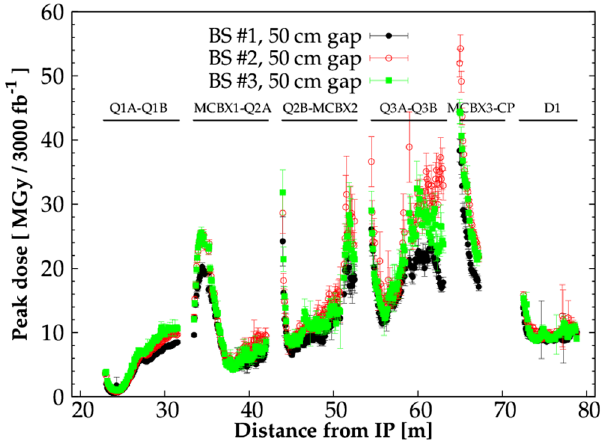
FIG. 14. Longitudinal distributions of peak dose on the inner coils of the IT magnets referring to different lengths of the beam screen gap in the